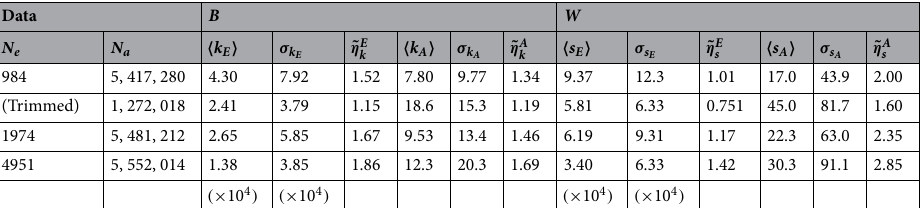
Table 1. Characteristics of the editor-article unweighted ( B ) and weighted ( W ) networks for the top 1000 (the actual number of editors N e after removing the bot-like ones is 984), 2000 ( N e = 1974 ), and 5000 ( N e = 4951 ) editors. For the top 1000 editors, the characteristics of the network after trimming the low-degree articles ( k A < 10 ) is shown together. (cid:31) k E (cid:30) and σ k E are the average and the standard deviation of the editors’ degree, and ˜ η E k is the average nestedness of the editors’ links relative to a configuration model with the same parameters ( (cid:31) k E (cid:30) and σ k E , see SI). The corresponding quantities for the links of articles are denoted by (cid:31) k A (cid:30) , σ k A , and ˜ η respectively. For the weighted networks ( W ), we show the average ( (cid:31) s E (cid:30) , (cid:31) s A (cid:30) ) and the standard deviation ( σ s E , σ s A ) of the strength, as well as the relative nestedness quantities calculated using the link weights, ˜ η ˜ η A s .